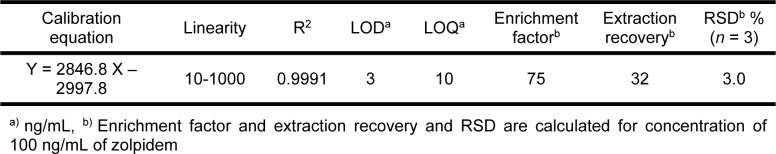
Analytical characteristics of EME-HPLC-UV analysis for zolpidem